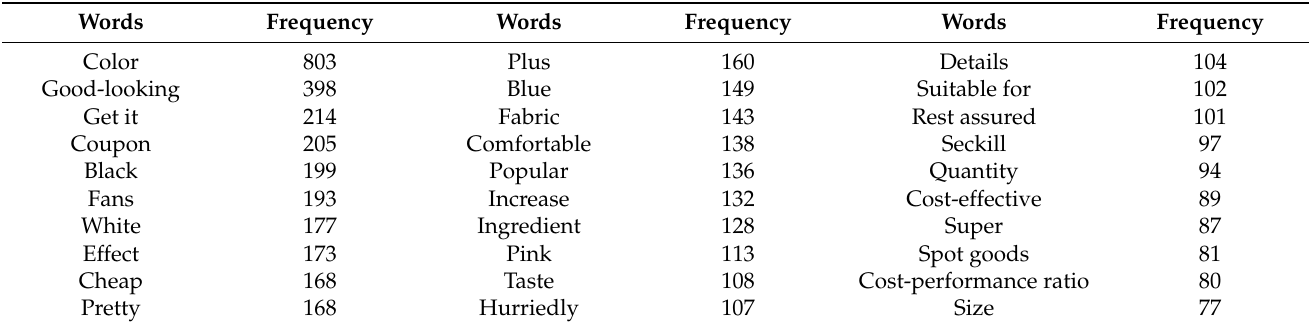
Table 1. Text word frequency statistics table.